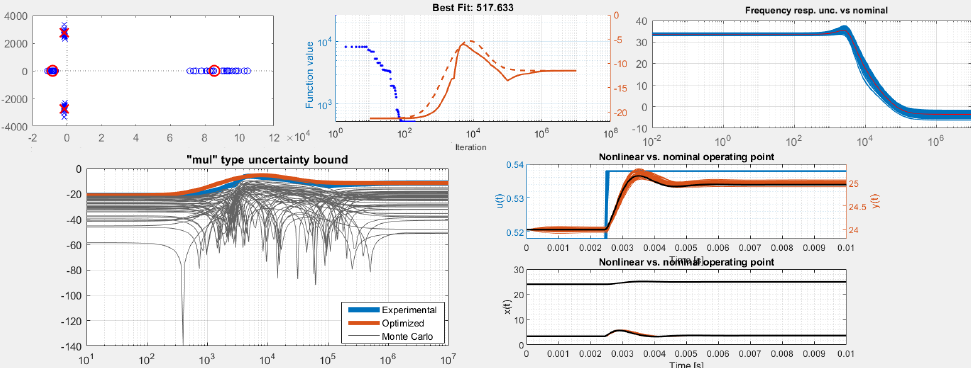
Figure 14. Boost multiplicative uncertainty set computation and open loop responses for the operat- ing point with E = 12 [ V ] , R = 15 [ Ω ] , U R = 24 [ V ] : step and frequency response, pole-zero placement; the step response is simulated for nonlinear plants sampled using UncertainPlantFactory